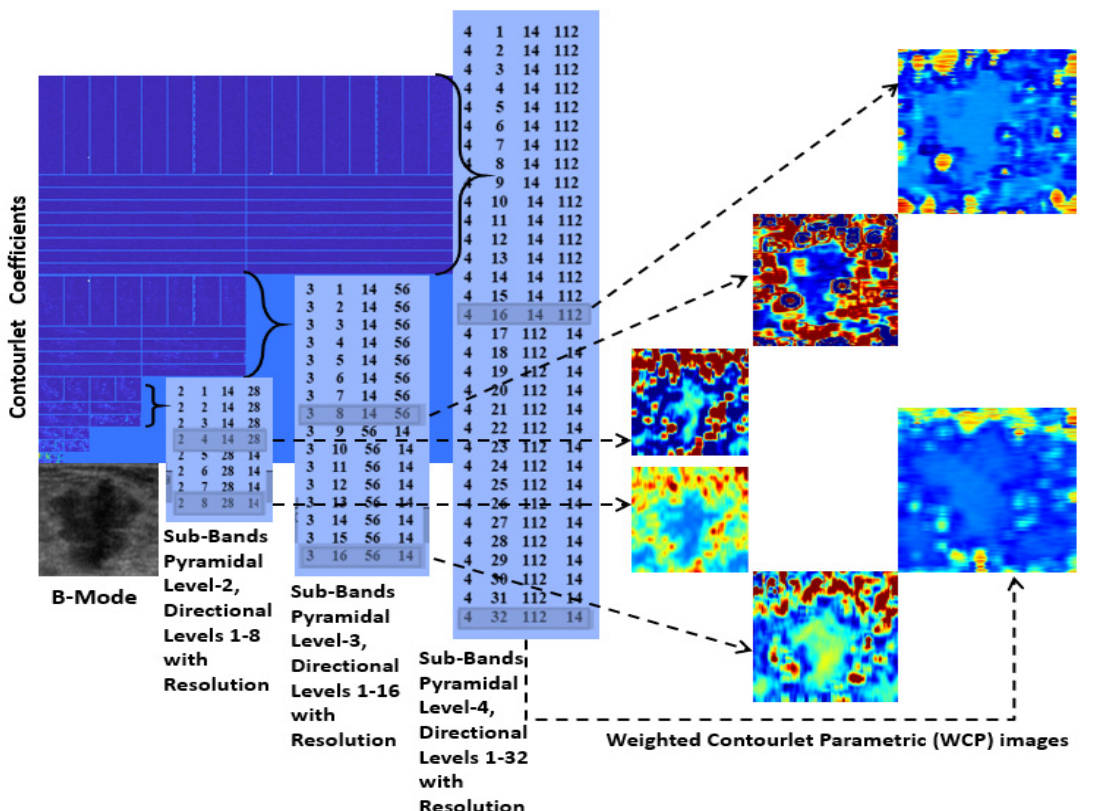
Figure 6. WCP images modeled by RiIG PDF at Contourlet sub-bands: pyramidal decomposition level-2 directional decomposition level-4 (P2D4), as well as P2D8, P3D8, P3D16, P4D16, and P4D32.